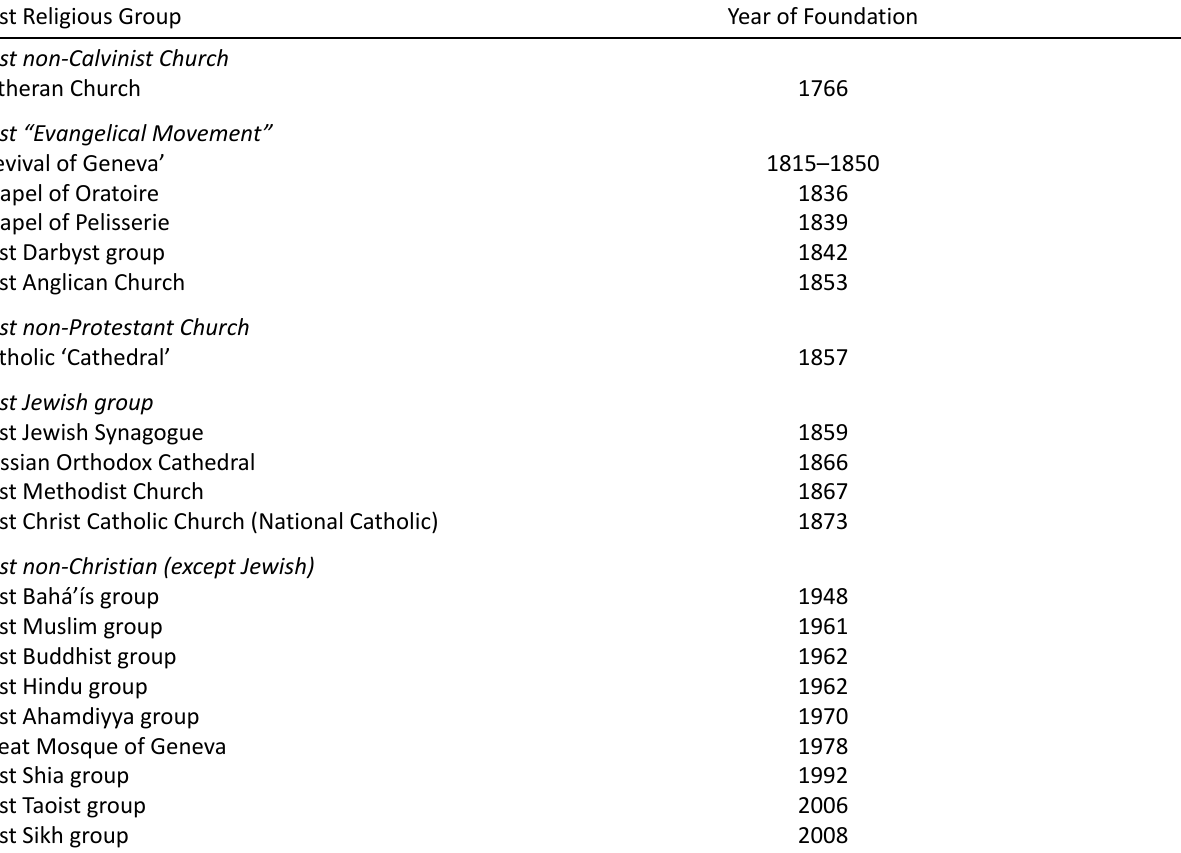
Table 1. Years of the establishment of diversity in the city of